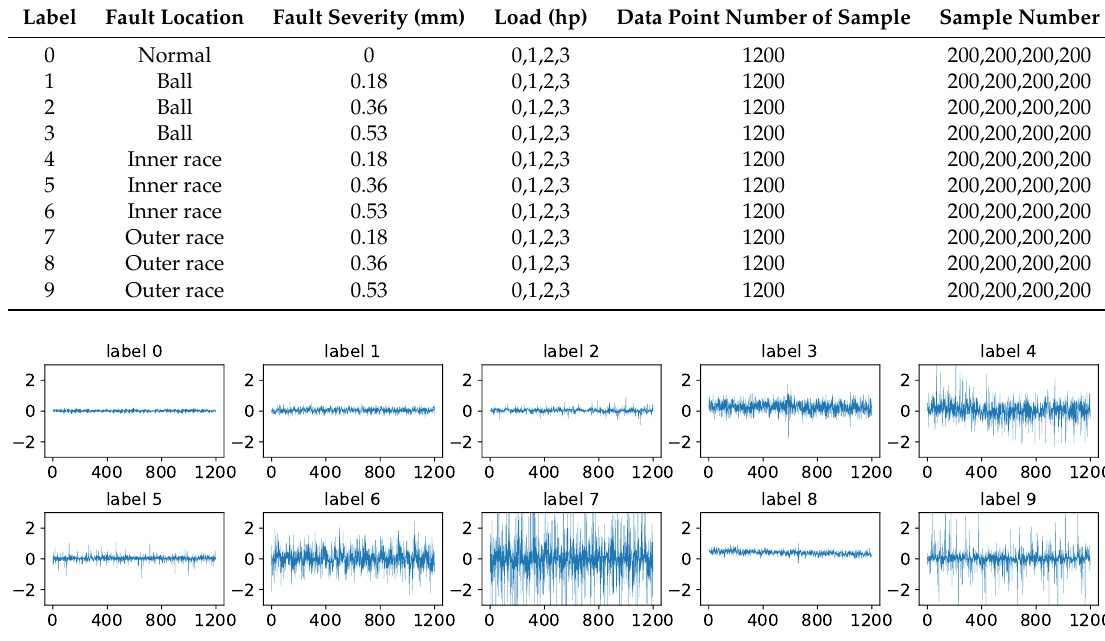
Figure 4. Each health condition